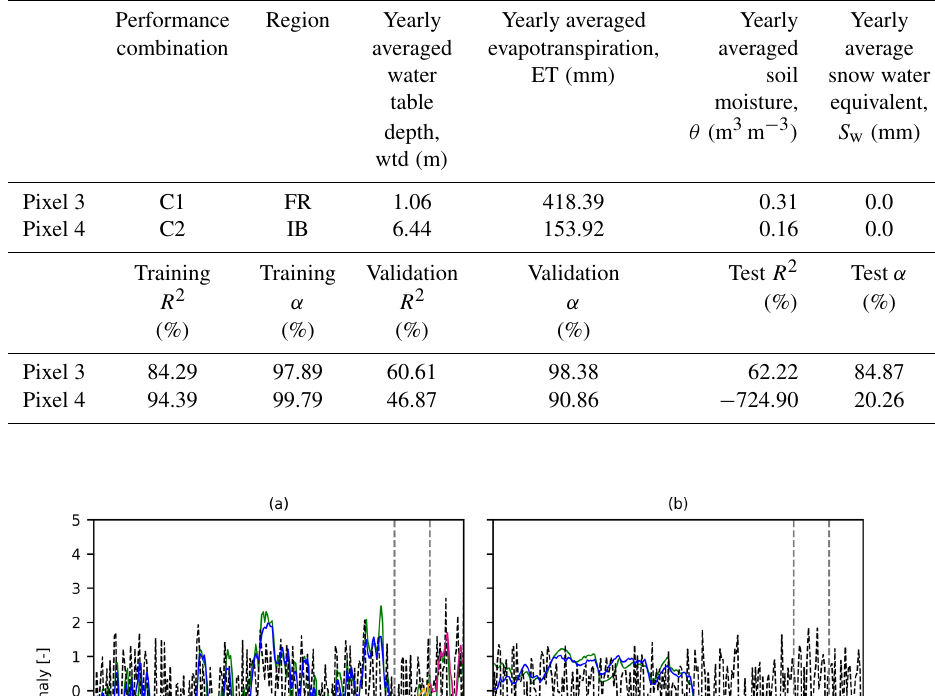
Table C1. Pixel characteristics in the XWT analysis (pixels 3–4).